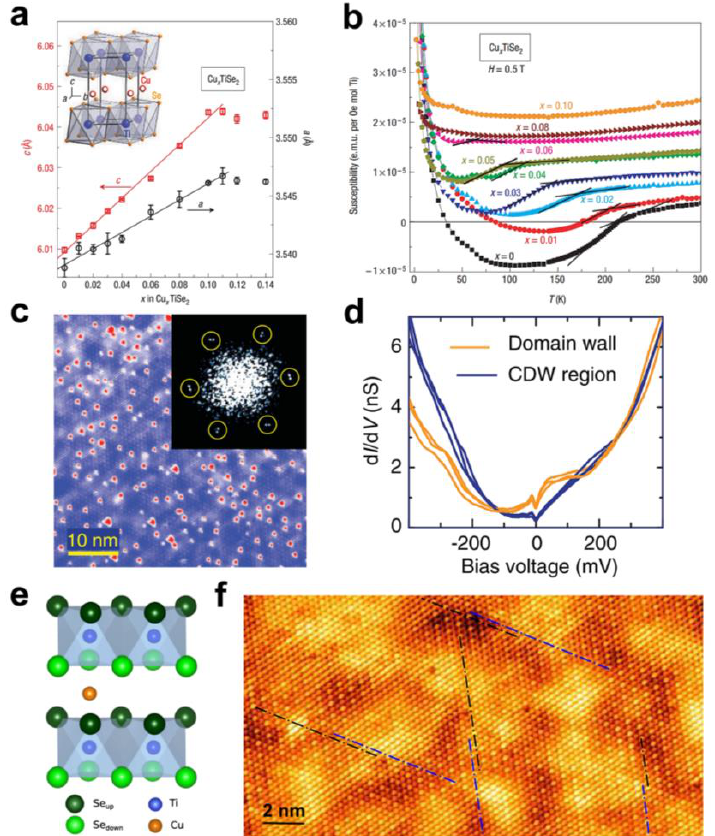
Figure 5. ( a ) The lattice constant of Cu x TiSe 2 varies with the Cu content, and the inset is a